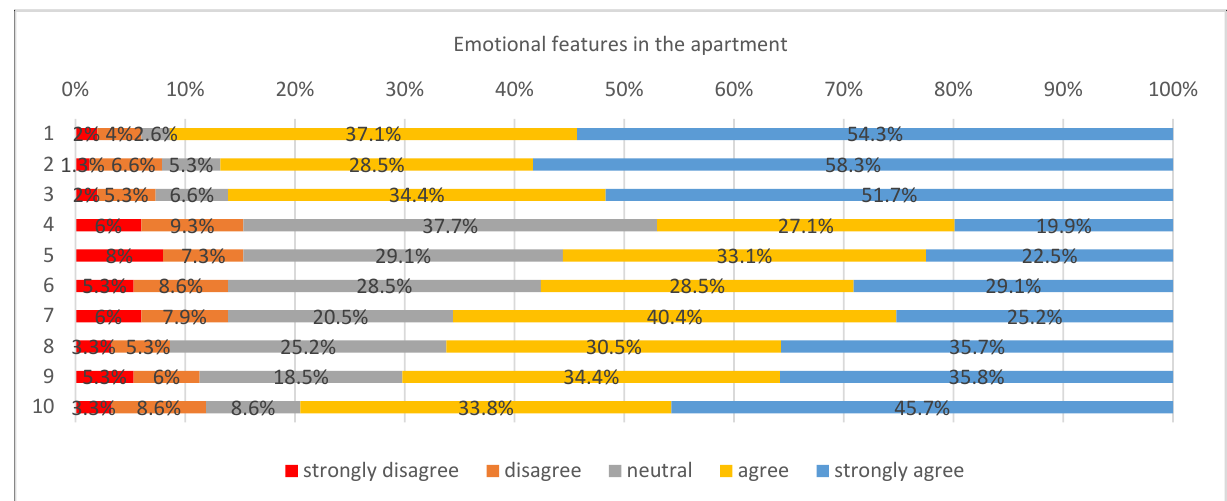
Figure 18. Emotional features of the apartment.